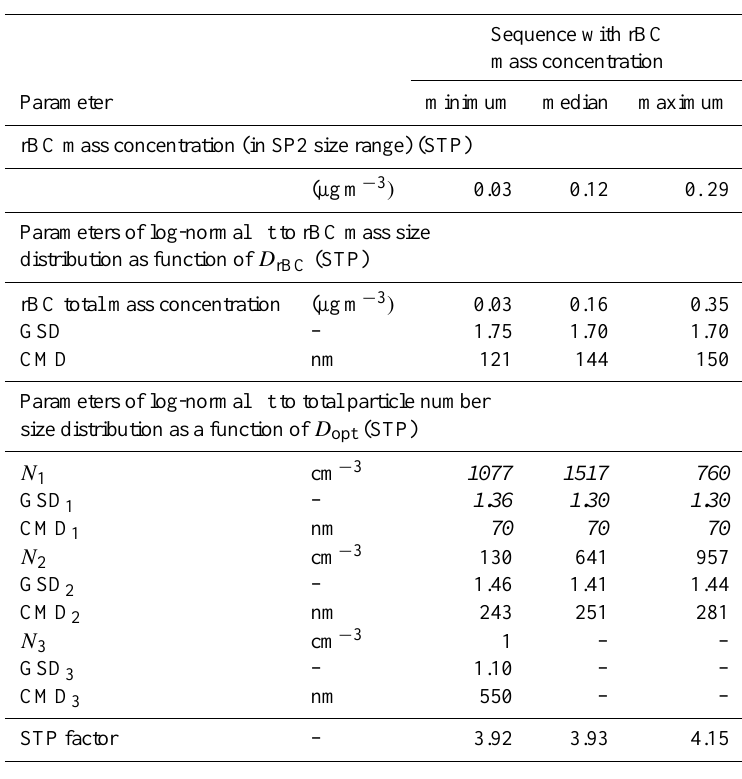
Table 2. rBC characteristics and characteristics of the total particle number size distributions in the Pagami Creek fire plume. Shown are the minimum, median, and maximum values of rBC mass concentrations, the parameters of the log-normal fit to the rBC mass size distribution, the parameters of the log-normal fit to the total number size distribution, and STP-ambient conversion factors of 14 sequences during the forest-fire aerosol layer measurements. Values in italics are extrapolated from total number concentration values. In comparison to the rBC mass concentration in the Pagami Creek fire within the SP2 size range (0.03–0.29µgm − 3 ) the free tropospheric background sequence has